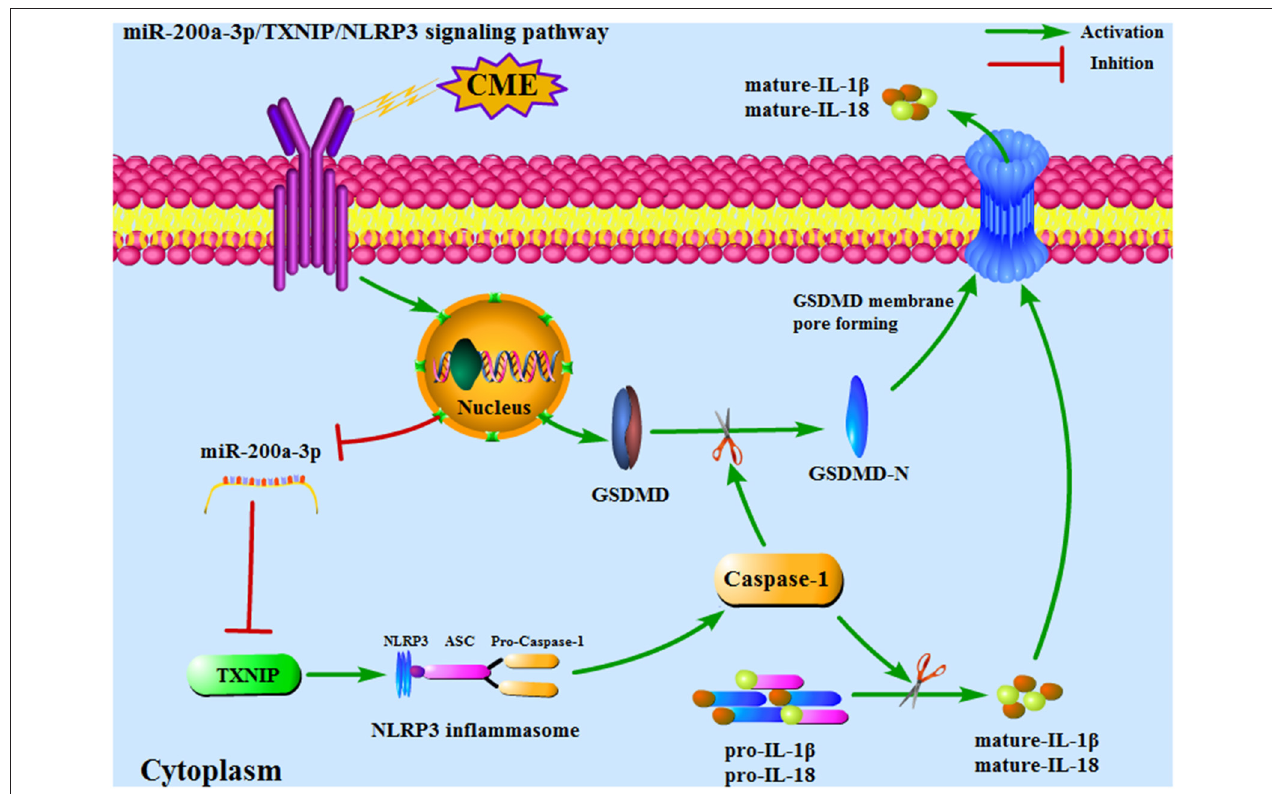
FIGURE 9 | An overview of the mechanisms whereby miR-200a-3p targets the TXNIP/NLRP3 signaling pathway to modulate cardiomyocyte pyroptosis. CME, coronary